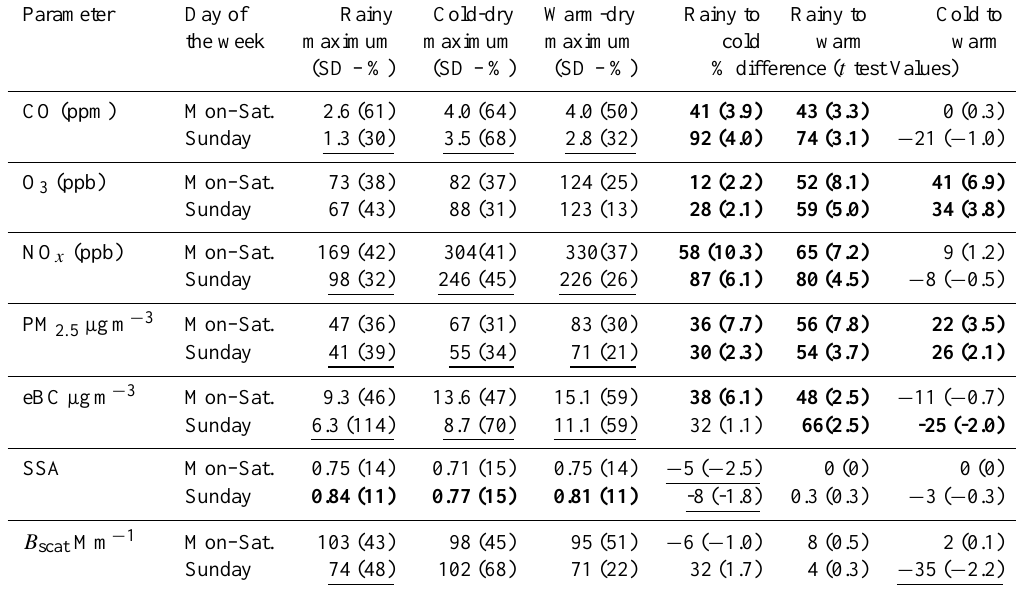
Table 2. Daily and seasonal maxima. Underlining indicates significant decrease at P <0.10. Bold indicates significant increase. Parameter Day of Rainy Cold-dry Warm-dry Rainy to Rainy to Cold to the week maximum maximum maximum cold warm warm (SD –%) (SD –%) (SD –%) % difference ( t test